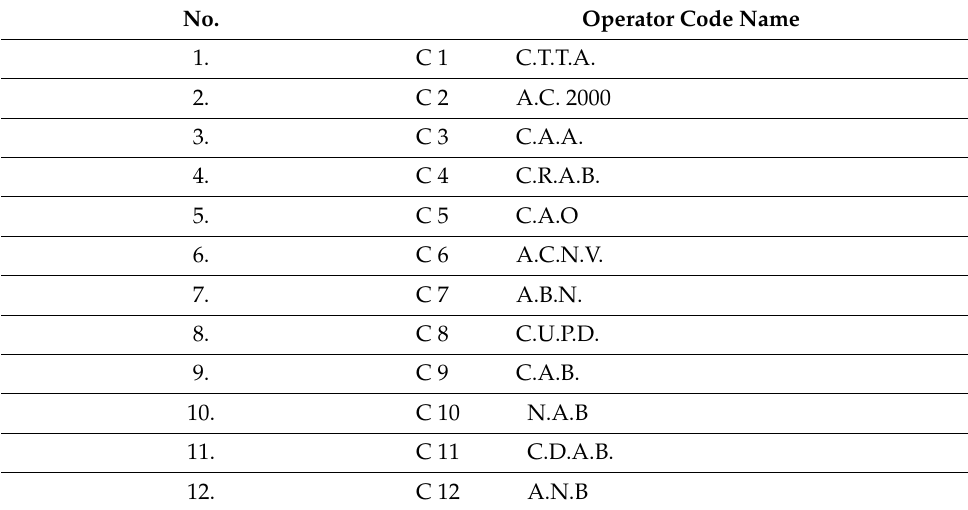
Table A1. Coded name of the analyzed